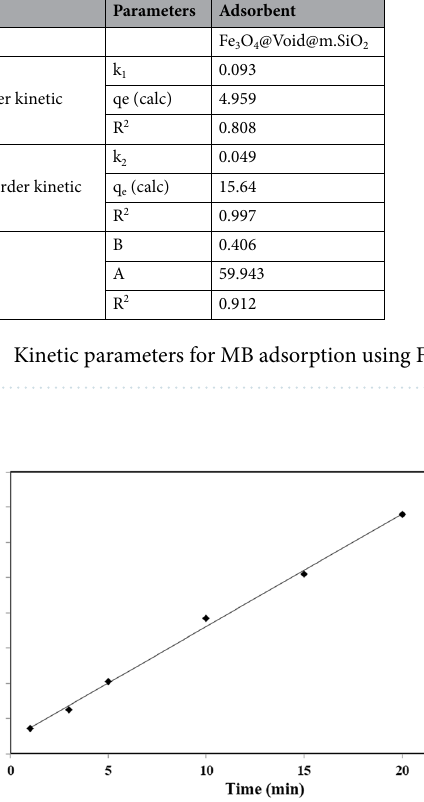
Figure 17. The pseudo-second-order plot of MB adsorption using Fe 3 O 4 @Void@m.SiO 2